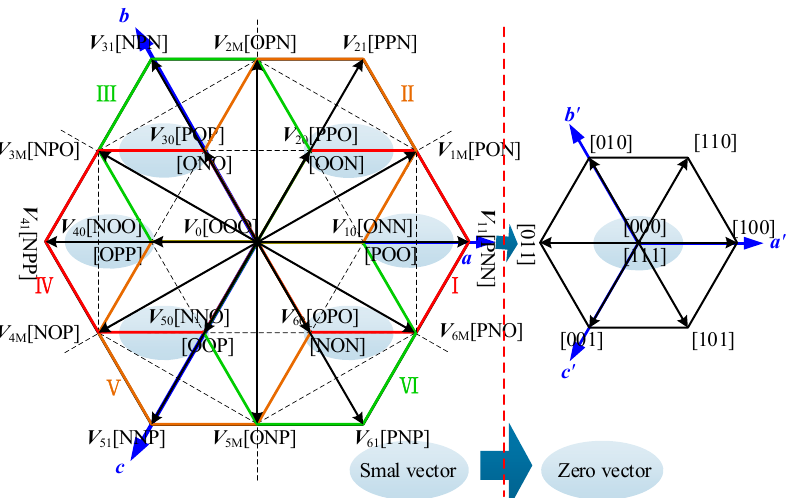
Figure 2. Equivalent process from three-level small-voltage vector to two-level zero-voltage vector.